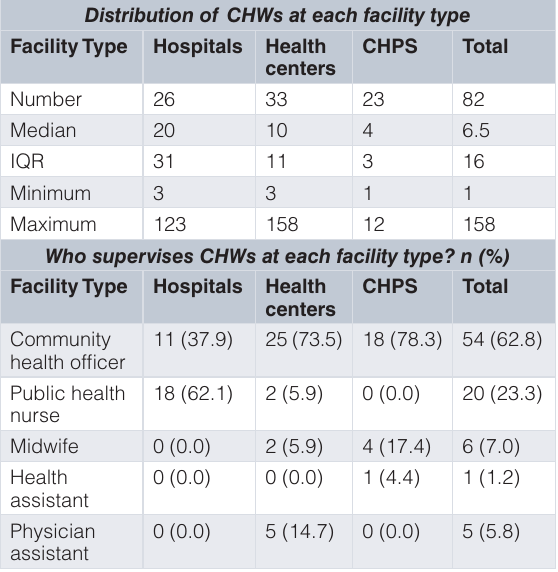
Table 5. Characteristics of community health worker (CHW) distribution and supervision by facility type.